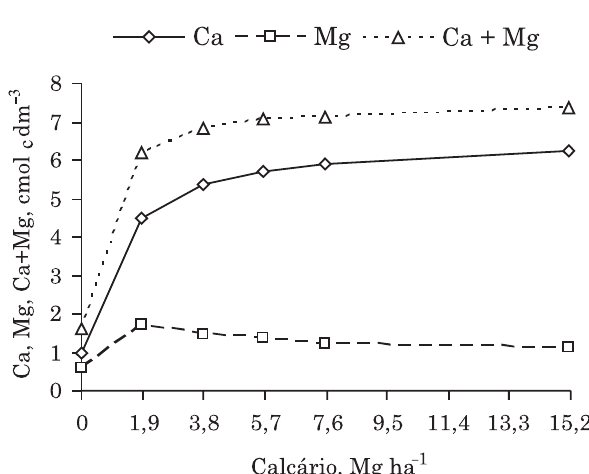
Figura 6. Teores de cálcio, magnésio e cálcio+ magnésio trocáveis, na camada 15 – 20 cm da coluna, de acordo com as doses crescentes de